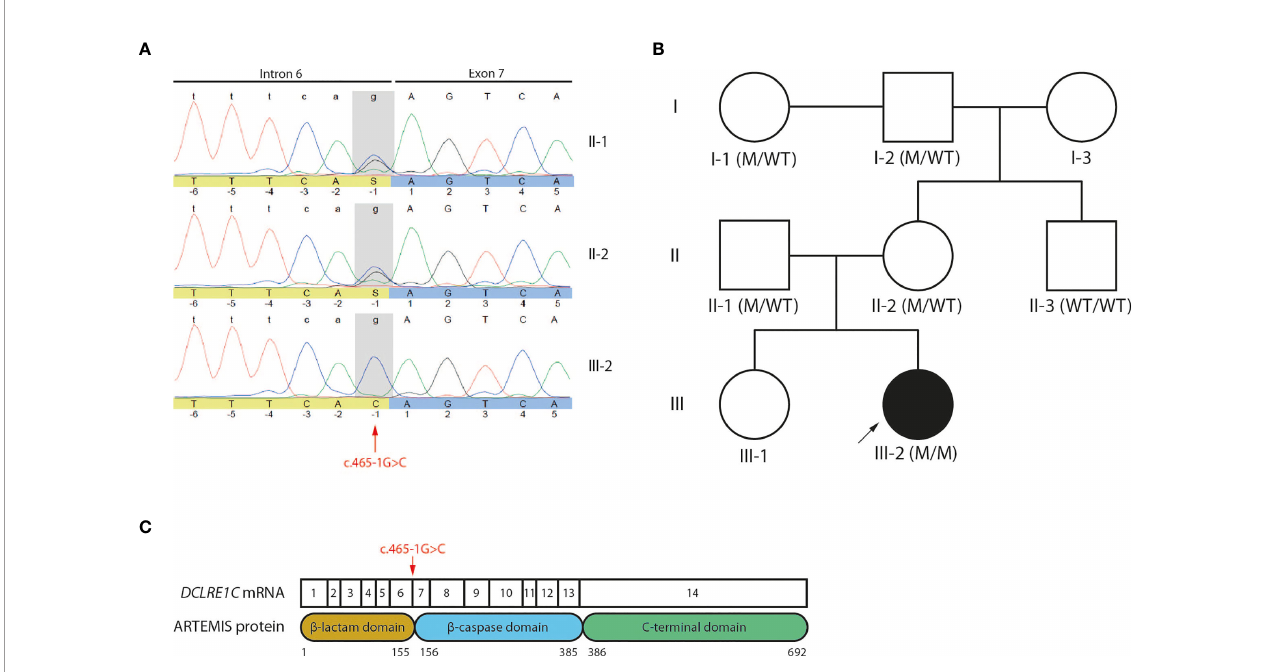
FIGURE 2 | Genetic analyses reveals a novel c.465-1G>C non-coding variant of the DCLRE1C gene (A) Sanger electropherogram of both the index patient and parents covering the region of the c.465-1G>C variant in the DCLRE1C gene. The location of the novel variant is indicated by the red arrow. (B) Pedigree of the affected family showing the prevalence of the variant across multiple generations. The index patient is depicted as a black circle and indicated by the black arrow. The genotype of every available family member is denoted. M, mutation; WT, wild-type. (C) Schematic representation of the canonical DCLRE1C transcript and the canonical ARTEMIS protein. The DCLRE1C transcript contains 14 coding exons. The ARTEMIS protein contains 3 protein domains consisting of 692 amino acids. The location of the variant is indicated by the red